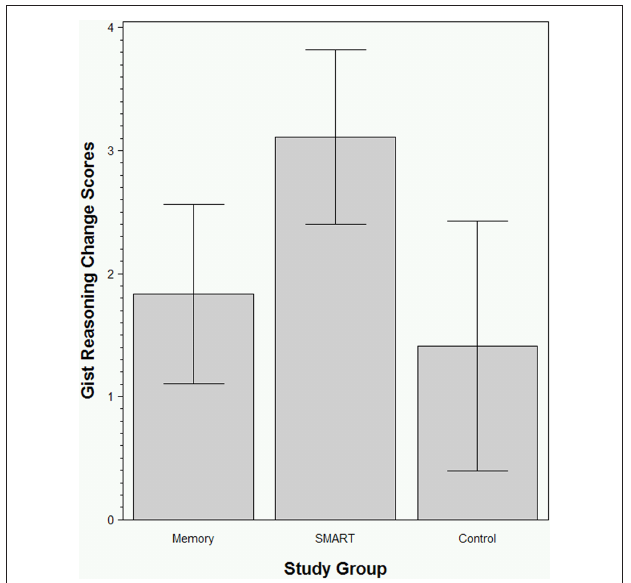
FiGuRe 1 | Changes in gist-reasoning scores after training programs for each group. Groups: Memory, Rote Memory Group; SMART, Strategic Memory and Reasoning Training Group; Control, Teen Brain Information